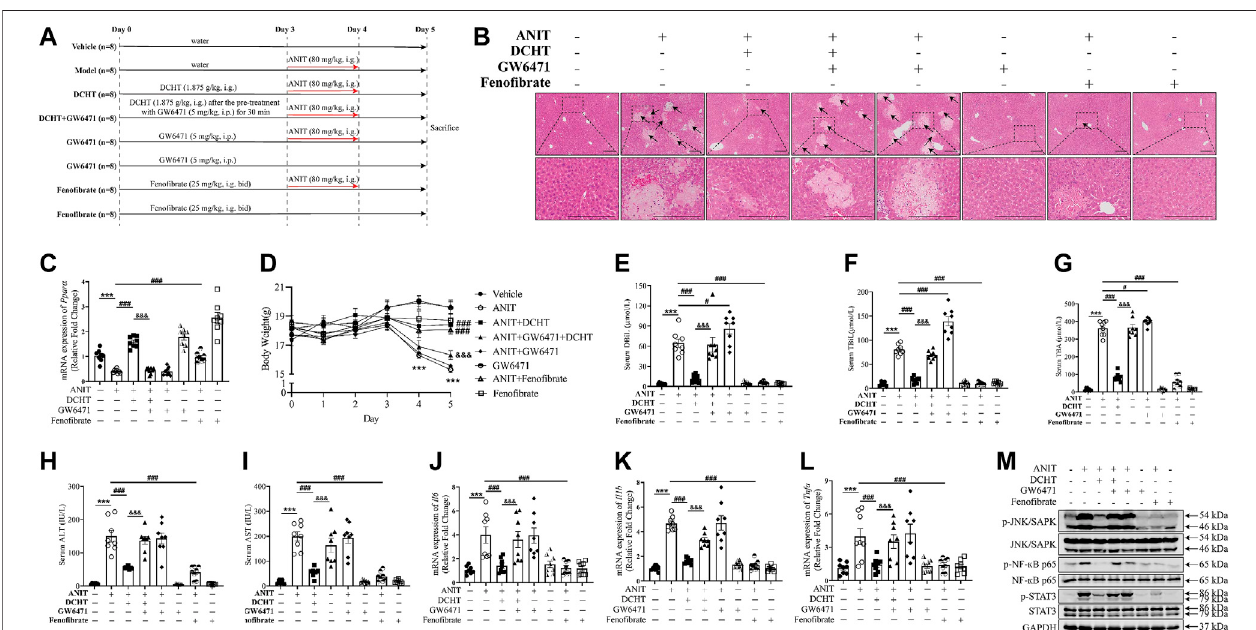
FIGURE 6 | DCHT protects against intrahepatic cholestasis via activation of PPAR α . (A) Scheme of the experimental design to study the effect of DCHT in combinationwithPPAR α antagonistGW6471,orthePPAR α antagonistGW6471,orthePPAR α agonistfeno fi brateinresponsetoANIT.MiceweretreatedwithANIT(2 days) and/or DCHT (5 days, 1.875 g/kg), GW6471 (5 days, 5 mg/kg) and feno fi brate (5 days, 25 mg/kg, bid) as indicated. (B) H&E-stained liver sections. Scale bar = 200 μ m. Arrows indicate the area of severe liver necrosis and hyperplastic bile cytoderm. (C) Hepatic expression of Ppara mRNA was measured by RT-qPCR. (D) Bodyweightsofallanimalswererecordeddaily. (E-I) SerumlevelsofDBiL (E) ,TBiL (F) andTBA (G) ,ALT (H) andAST (I) . (J-L) expressionofthe Il6 (J) , Il1b (K) and Tnfa (L) mRNAs in the liver was measured by RT-qPCR (M) Protein levels of p-JNK/SAPK, JNK/SAPK, p-STAT3, STAT3, p-NF- ĸ B p65, NF- ĸ B p65 and GAPDH were measured by immunoblot. Data are shown as means ± SEM.; *** p < 0.001 ANIT treatment group compared with the vehicle group; # p < 0.05, ### p < 0.001 compared with the ANIT treatment group; &&& p < 0.001 ANIT + GW6471 + DCHT group compared with ANIT + DCHT group, n =